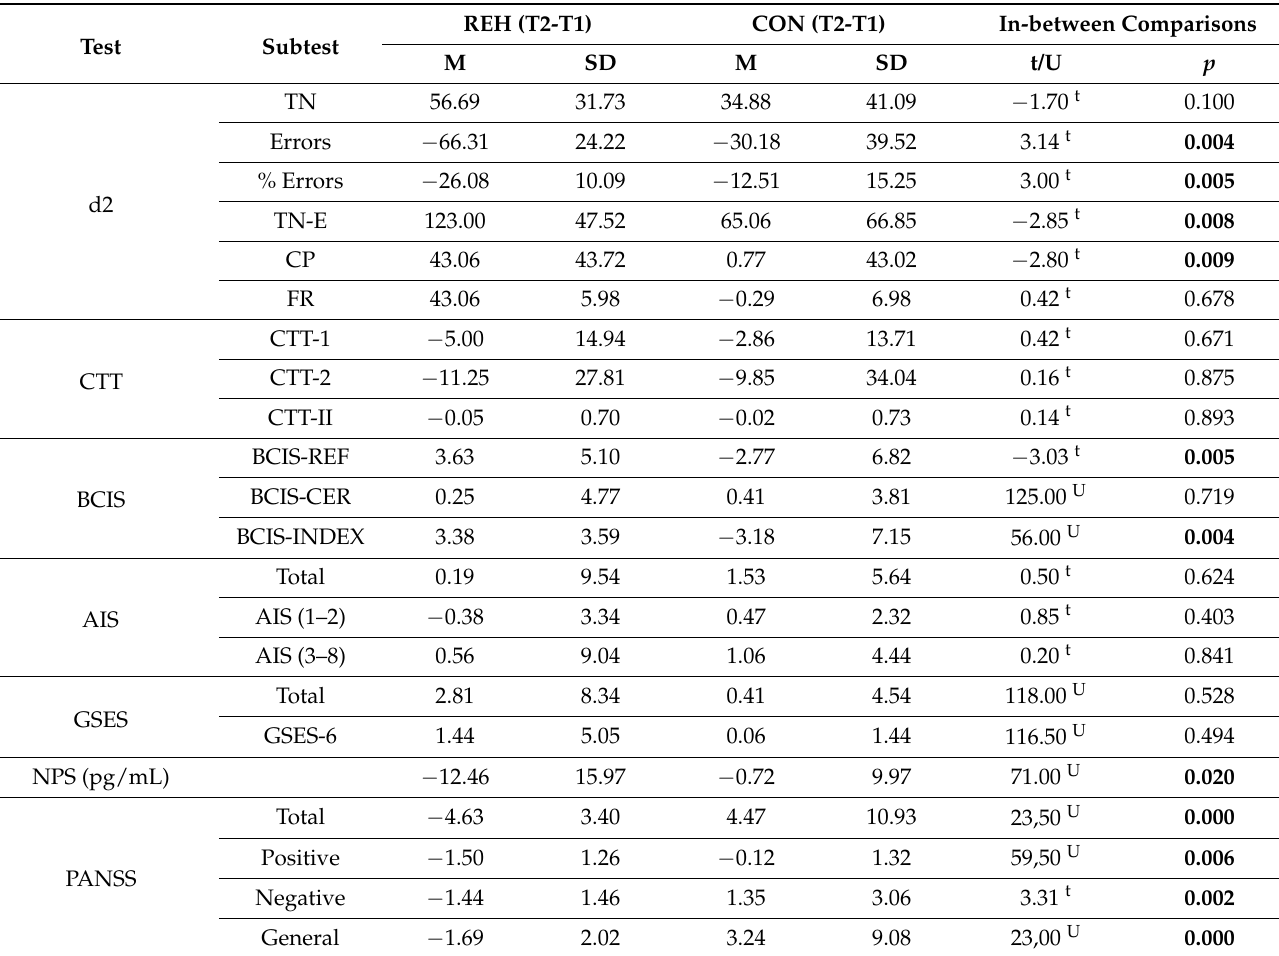
Table 3. Differences in the magnitude of change from pre- (T1) to post-therapy (T2) results in REH and CON